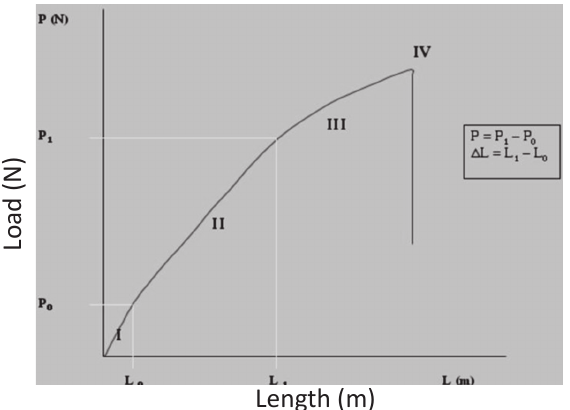
Figure 2- Tension x deformation curve of polyurethane specimen subjected to tension